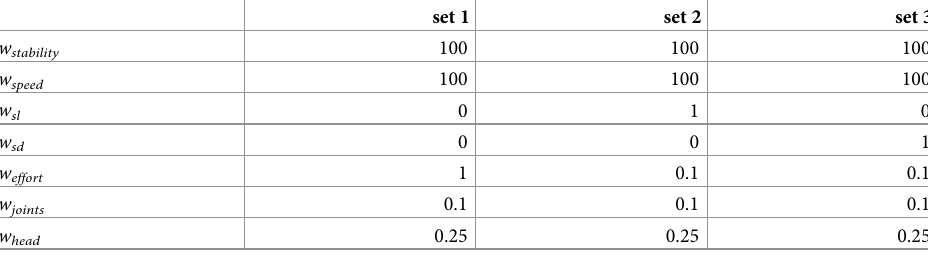
Table 1. Assigned weight for each component of the cost function for the three optimization sets. set 1 set 2 set 3 w